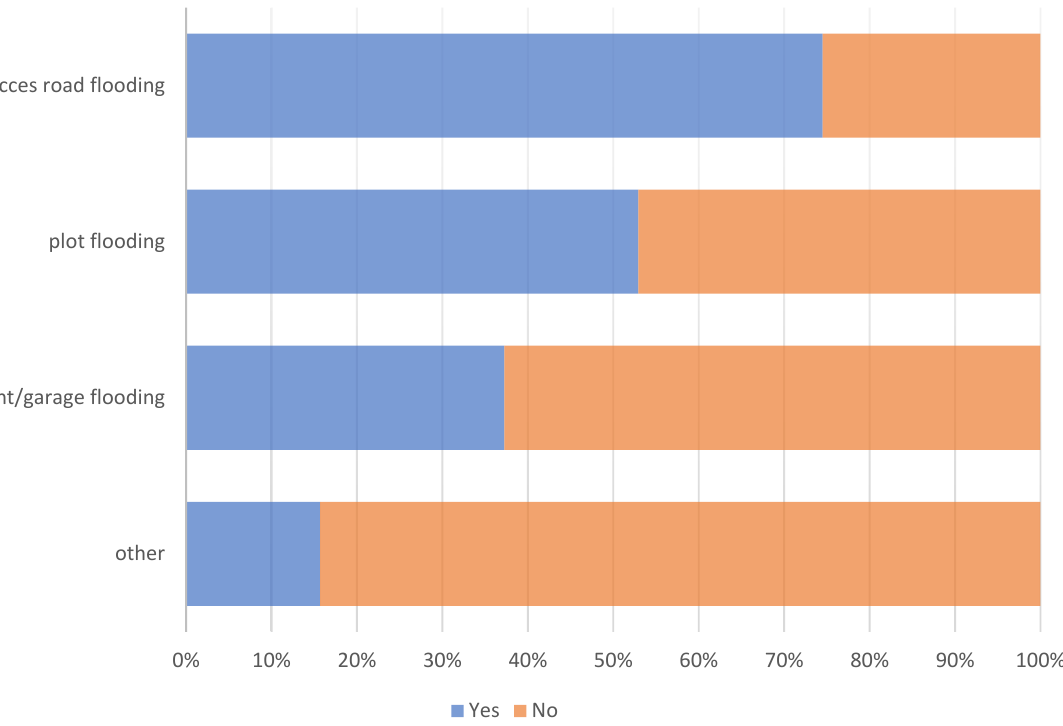
Figure 3. Form of local flooding among respondents declaring occurrence of flooding ( n = 51). Source: own study based on questionnaire research. This is a figure.